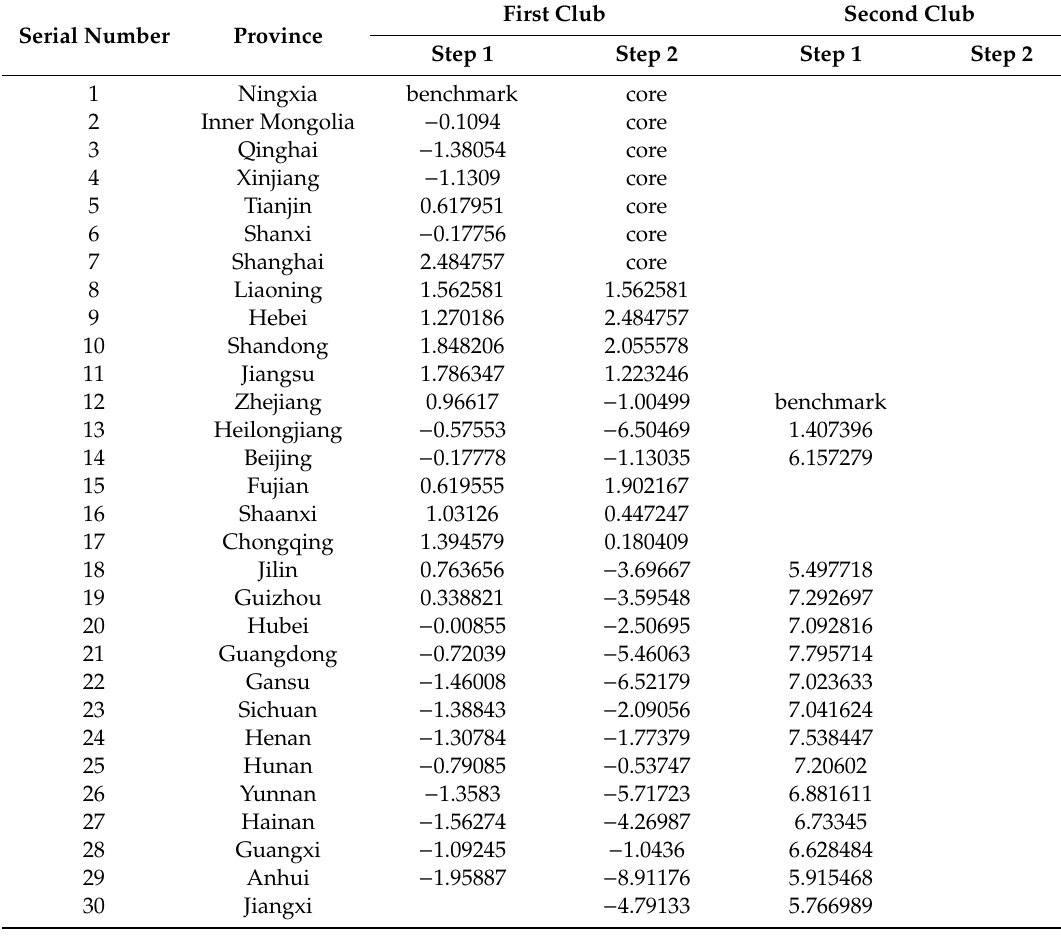
Table 3. Division and order of clubs in 30 provinces.